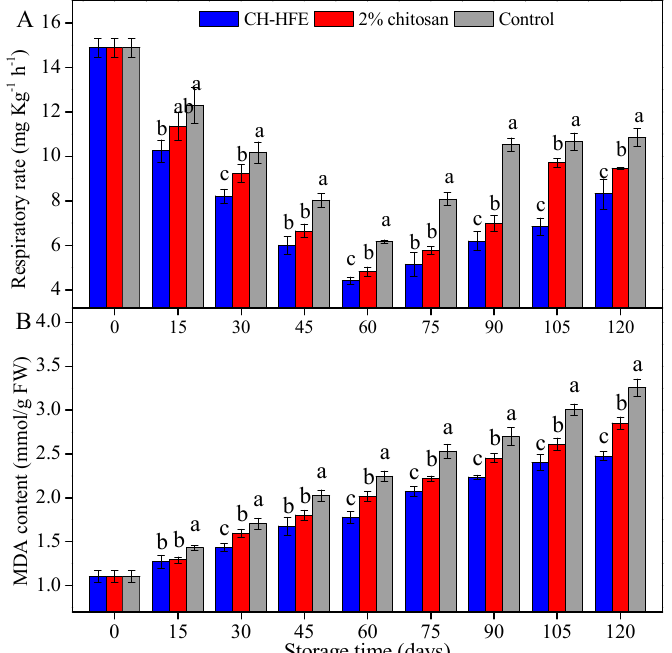
Figure 4. Changes in respiration rate ( A ) and malondialdehyde (MDA) content ( B ) of navel orange fruits stored at 5 °C for 120 days. Bars indicate standard error of three replicates, each consisting of 30 randomly selected fruits.